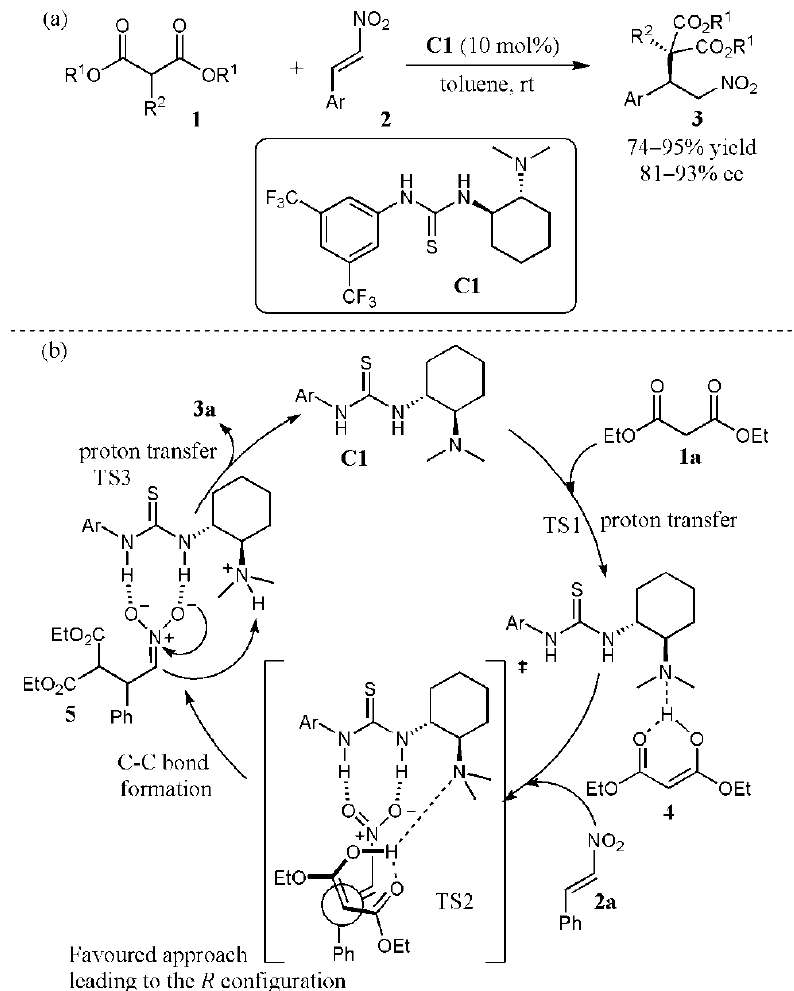
Figure 2. The first bifunctional thiourea-catalyzed reaction ( a ) and its mechanism ( b ) [16,17]. Soon after, two theoretical studies were reported with conflicting results. Liu and coworkers identified, through DFT calculations, proton transfer to the nitronate carbon of complex 5 as the rate-determining step in the catalytic cycle [18]. Papái and coworkers identified two possible binding modes, A and B, for TS2, in which either the nitronate bonds to the thiourea moiety and the diester to the tertiary amine (binding mode A) or vice versa (binding mode B) (Figure 3) [19]. It was calculated that binding mode B is energetically favored by 2.7 kcal mol − 1 and that carbon–carbon bond formation is the rate-determining step. Other studies have been performed on this reaction and